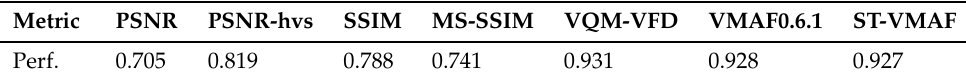
Table 1. Some results from [21] on Netflix data, indicating VMAF and VQM-VFD perform well on Netflix databases. Metric PSNR PSNR-hvs SSIM